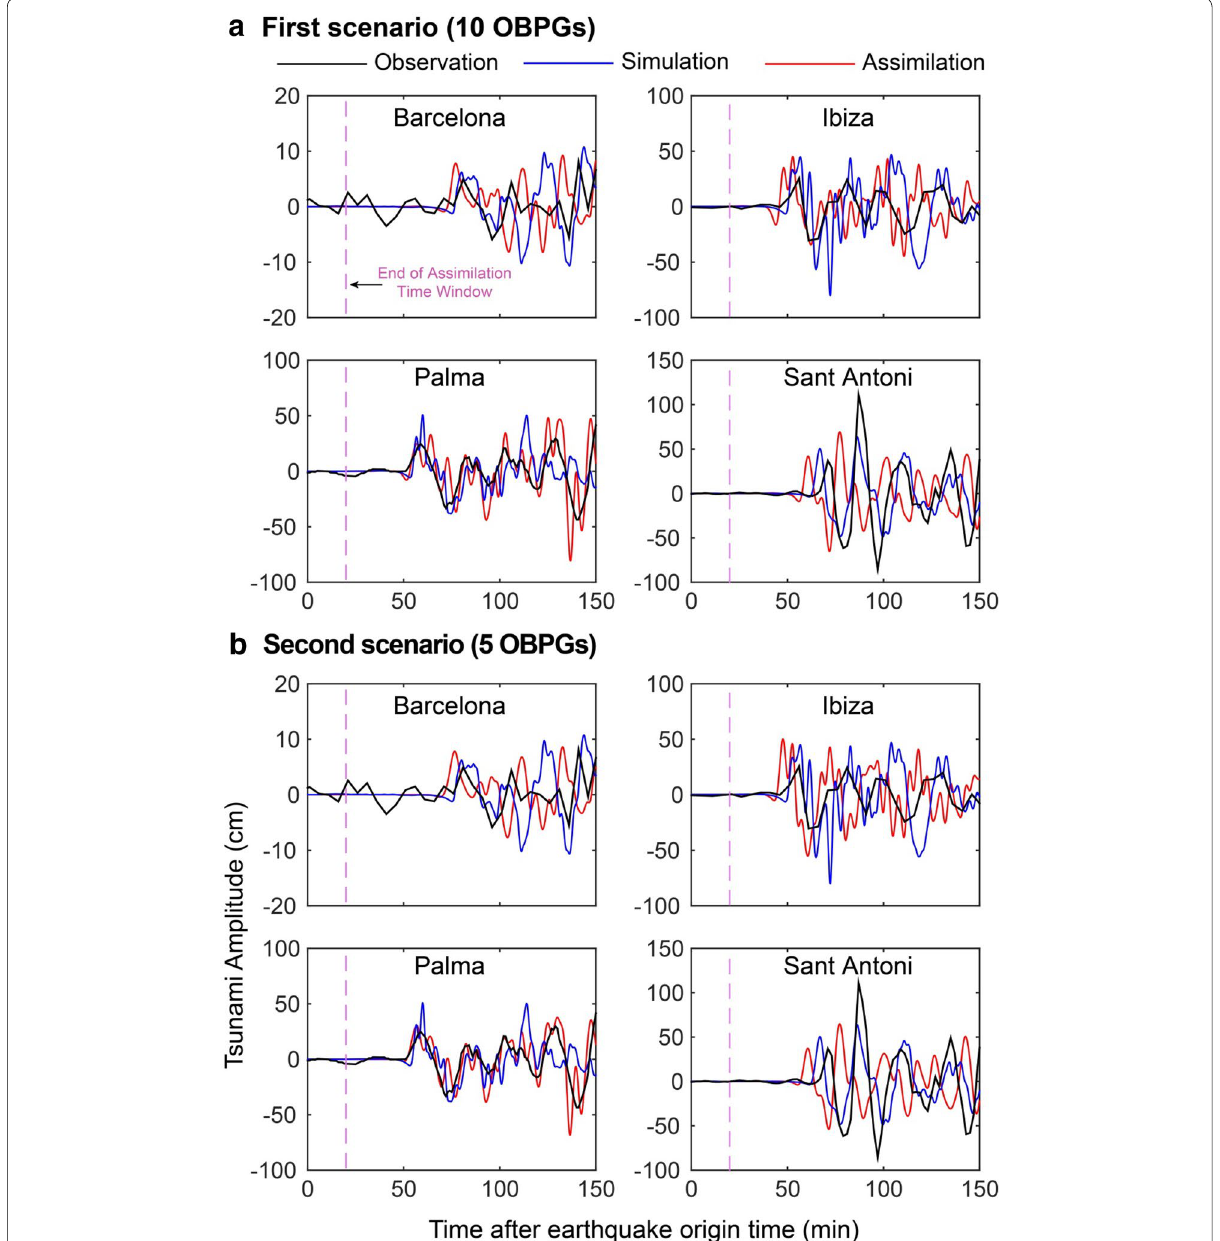
Fig. 6 Comparison of the observations (black lines), simulation (blue lines) and forecasted (data assimilation; red lines) waveforms at four PoIs for the first ( a ; 10 OBPGs) and second ( b ; five OBPGs) scenarios. The time window for assimilation is 20 min (dashed vertical